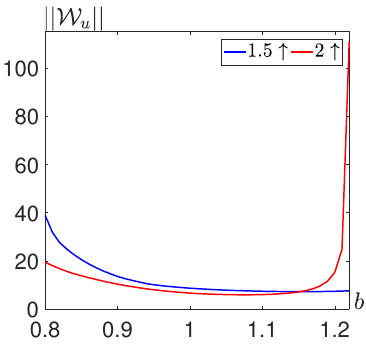
Figure 10. Stochastic sensitivity ||W u || of 1.5 ↑ and 2 ↑ patterns in Systems (1), (2) with a = d = e = 0.5, c = 1, D u = 5 × 10 − 4 , D v =